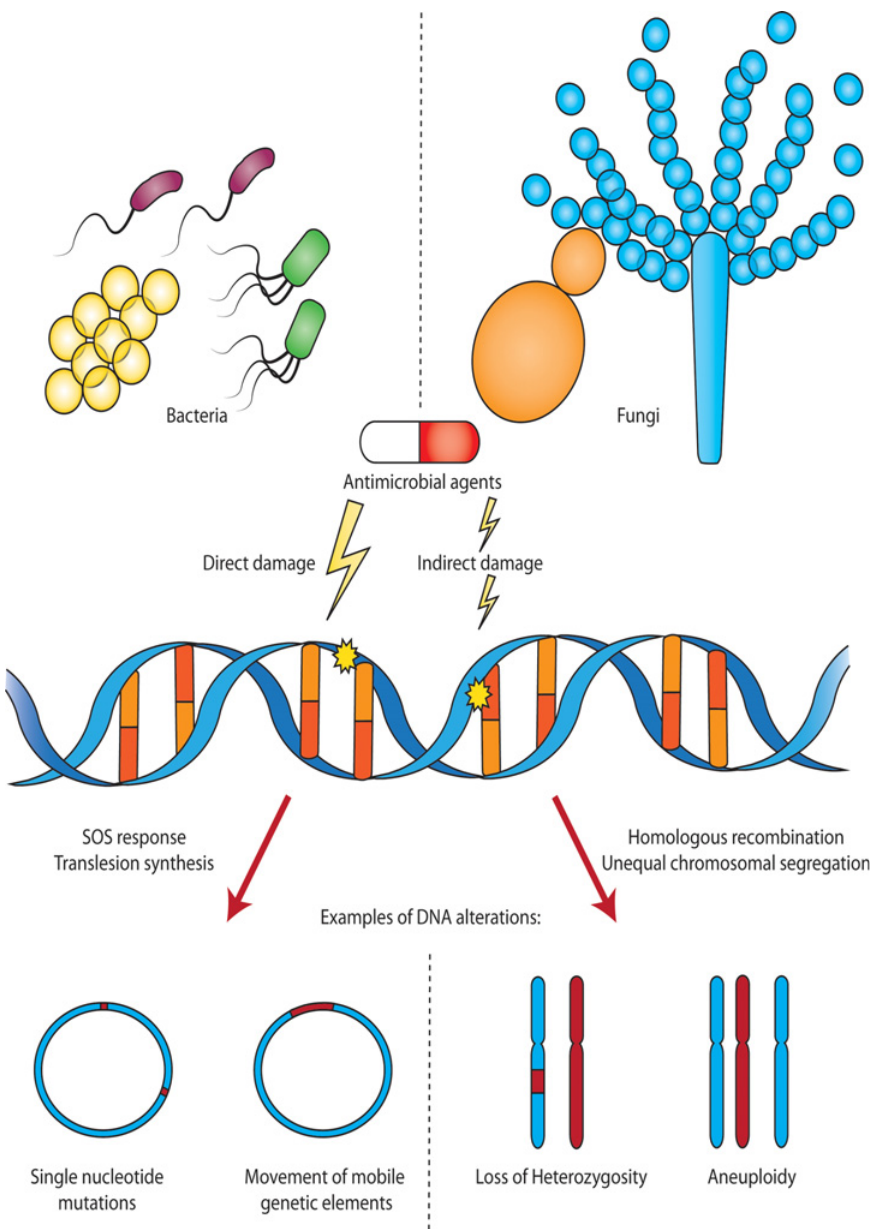
Fig 1. Antimicrobial-induced DNA damage in bacterial and fungal pathogens. Sublethal doses of antimicrobial agents can directly or indirectly damage DNA in bacteria and fungi. In bacteria, DNA damage may lead to up-regulation of an SOS response, error-prone translesion DNA synthesis, or other stress responses that result in mutations including single nucleotide polymorphisms (SNPs) and the movement of mobile genetic elements. In fungi, treatment with antifungals can lead to DNA damage, resulting in homologous recombination and loss of heterozygosity (LOH), or other cellular stress responses, leading to unequal chromosomal segregation during mitosis and aneuploidy. Bacteria and fungi are not to